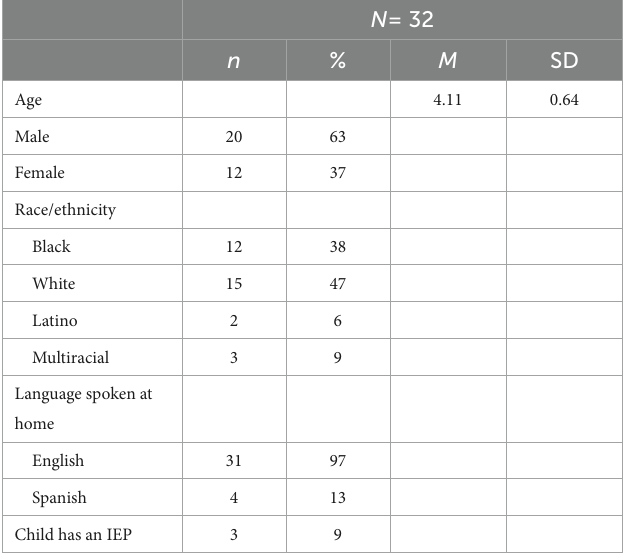
TABLE 2 Served children’s socio-demographic characteristics.